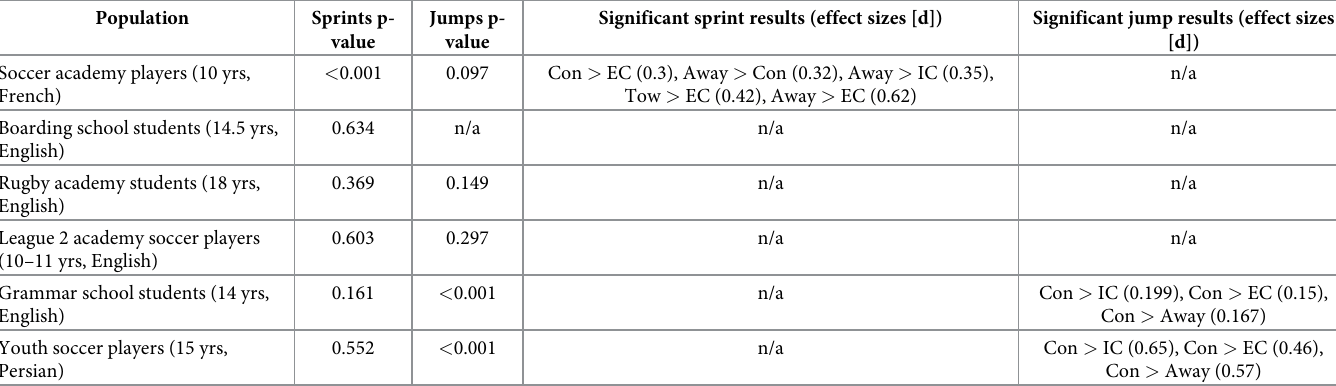
Table 3. Repeated measures analysis for the various coaching cues for both sprints and